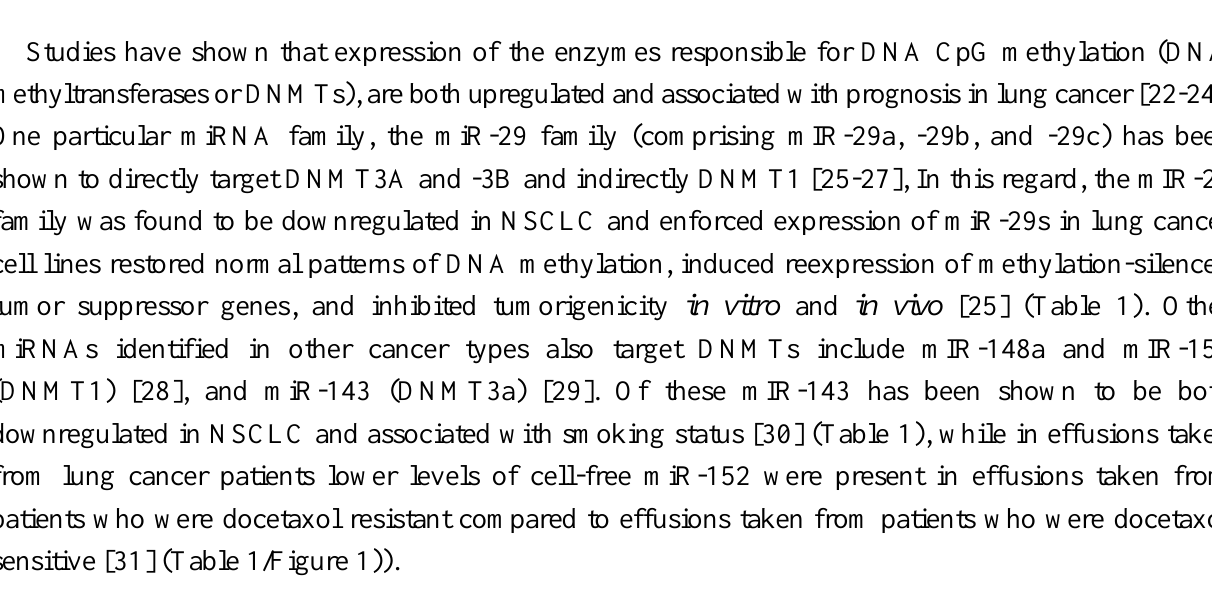
Table 1. miRNAs known to target epigenetic machinery and cisplatin resistance in non- small-cell lung cancer